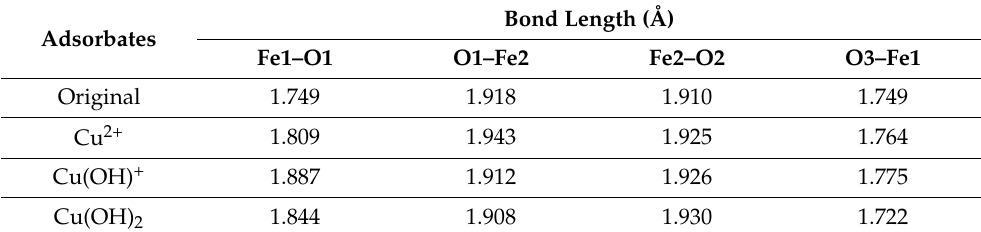
Table 1. Neighboring bond length before and after Cu species adsorption on specularite (0 0 1) surface. Adsorbates